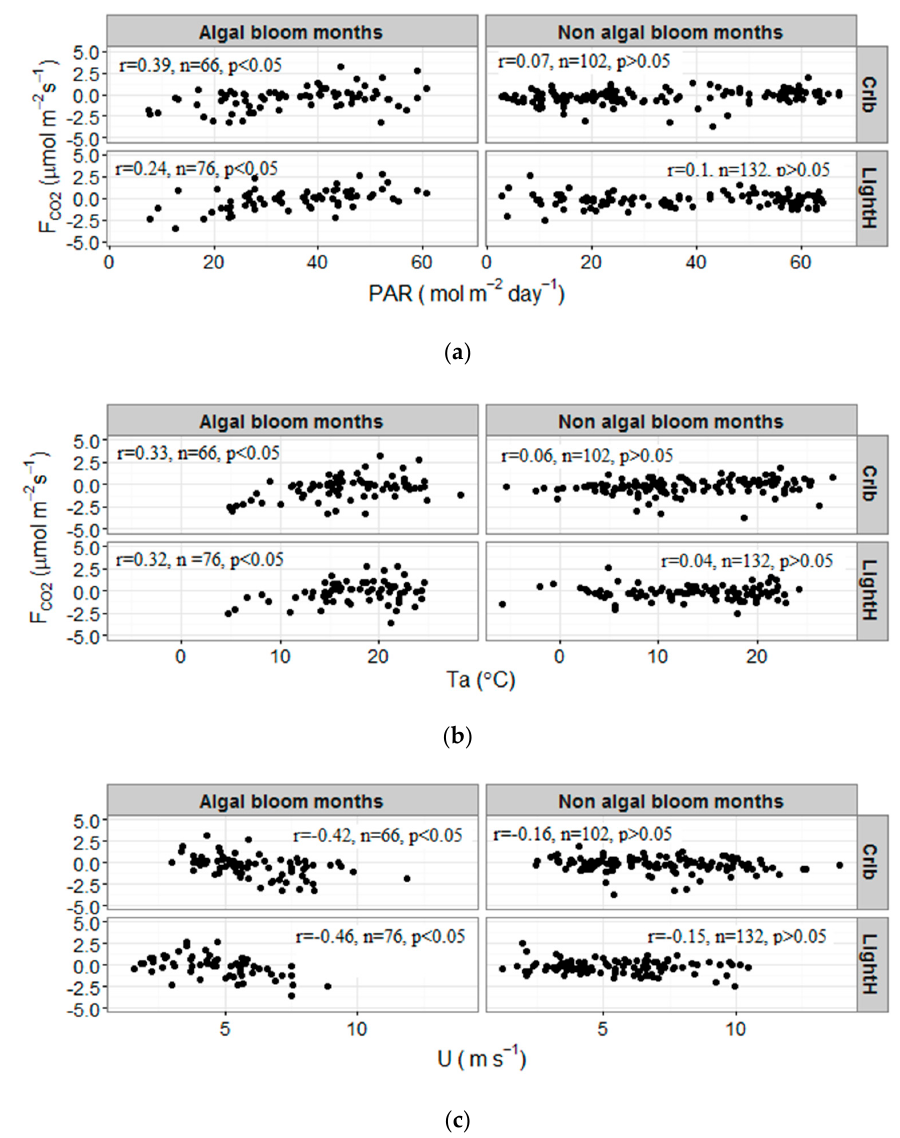
Figure 6. ( a – c ) Changes of daily F CO2 with photosynthetically active radiation (PAR), air temperature (Ta), and wind speed (U) at the LightH and Crib sites during algal bloom months and non-algal bloom months. Significant correlations were observed during algal bloom months ( p < 0.05) but not for non-bloom months (p > 0.05).